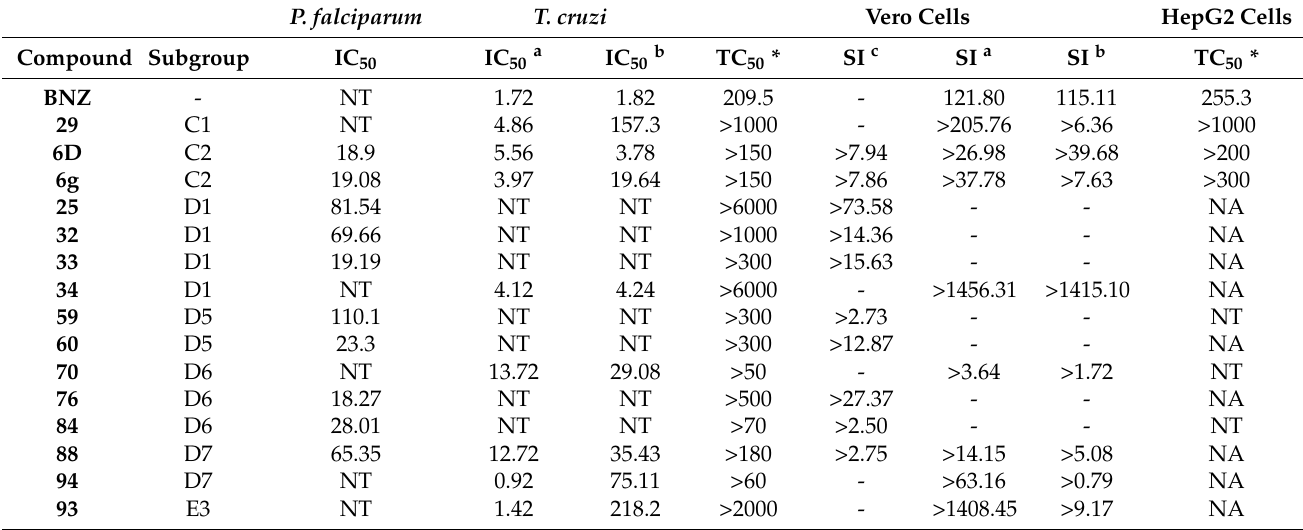
Table 2. IC 50 ( µ M), TC 50 ( µ M), and SI values of active compounds against P. falciparum and T. cruzi